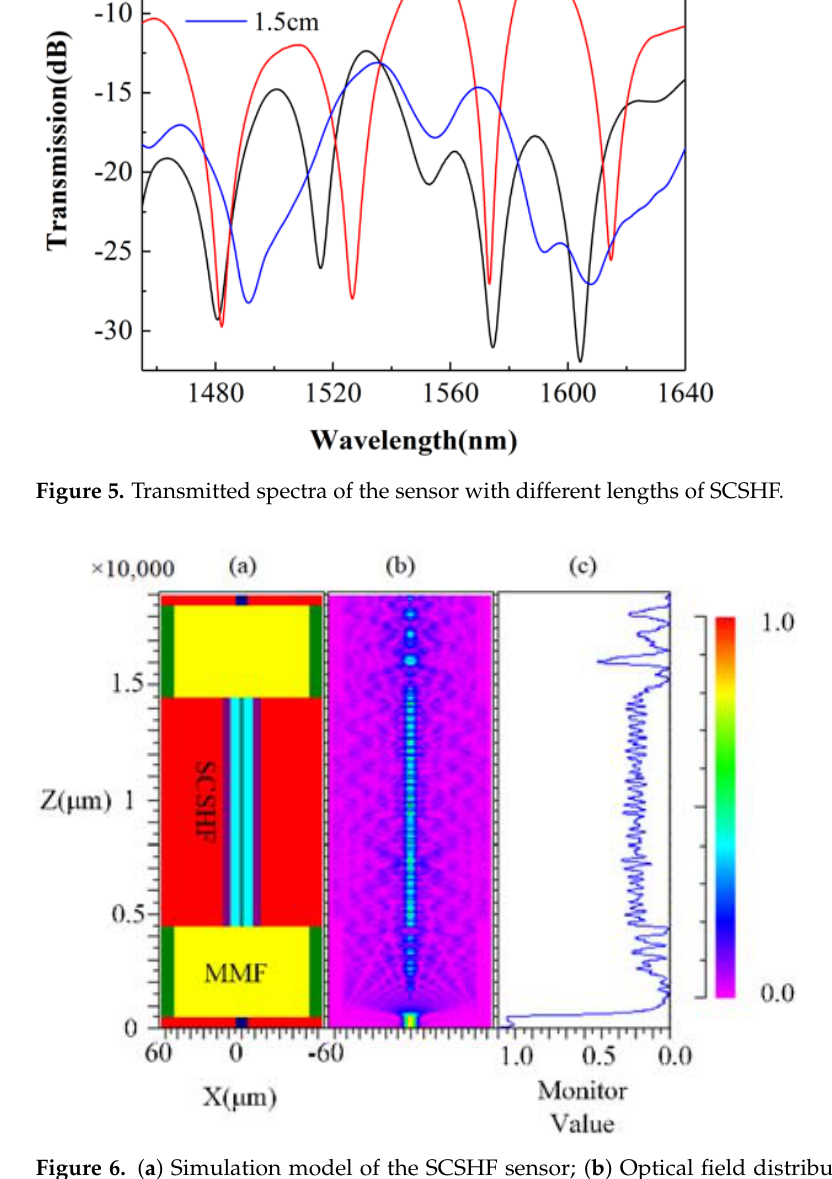
Figure 6. ( a ) Simulation model of the SCSHF sensor; ( b ) Optical field distribution in the SCSHF sensor; ( c ) Relative value of light intensity in the SCSHF sensor. Table 2. Simulation parameters of SCSHF